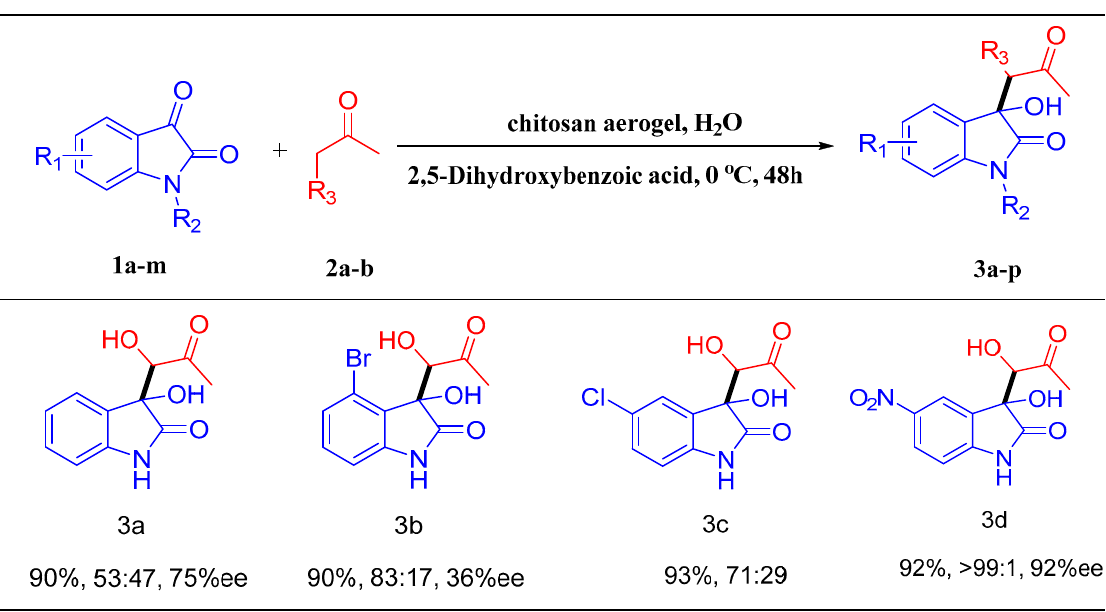
Table 4. Asymmetric aldol reaction between various isatins and ketones catalyzed by chitosan aerogel under optimized conditions a,b,c,d .